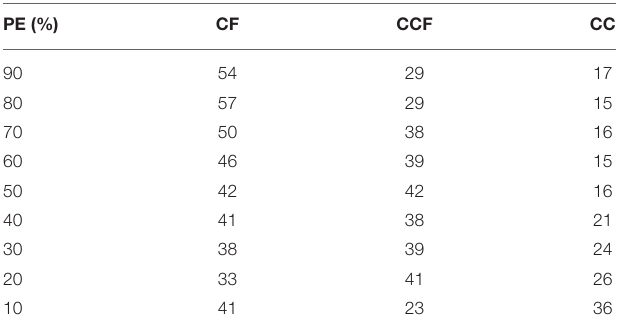
TABLE 3 | Percent of cells in each agroecological class in the dryland region of the Inland Pacific Northwest (crop/fallow (CF), annual crop/fallow transition (CCF) and continuous cropping (CC)) for the historical period (1979–2010) at different probabilities of exceedance (PE).